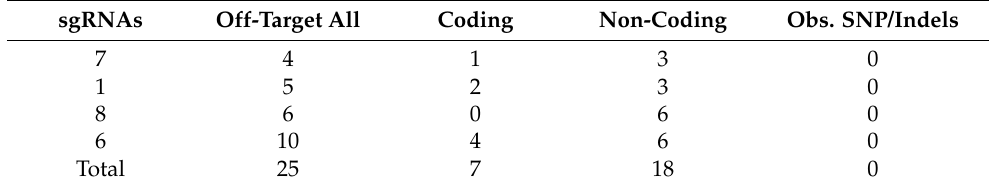
Table 3. Statistics on PMR4 off-target regions analyzed in all the assayed genotypes and in the San Marzano unedited plants.